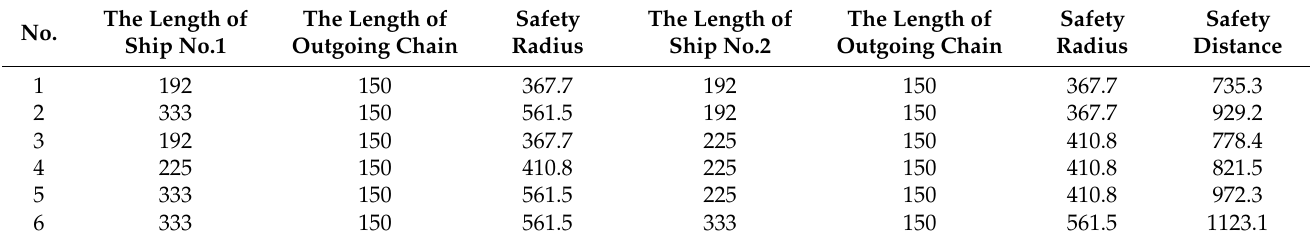
Table 4. Data of ships in safety distance with wind ≤ 7 (water depth 20 m) (unit: m).